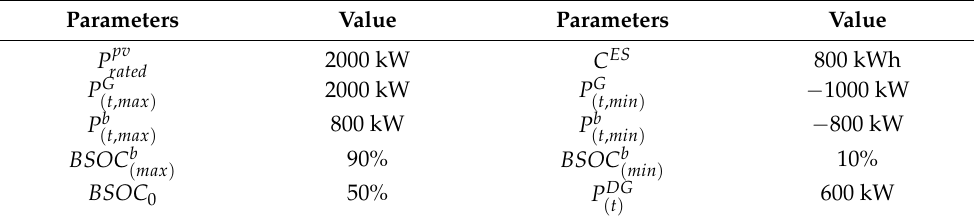
Table 2. System parameters.